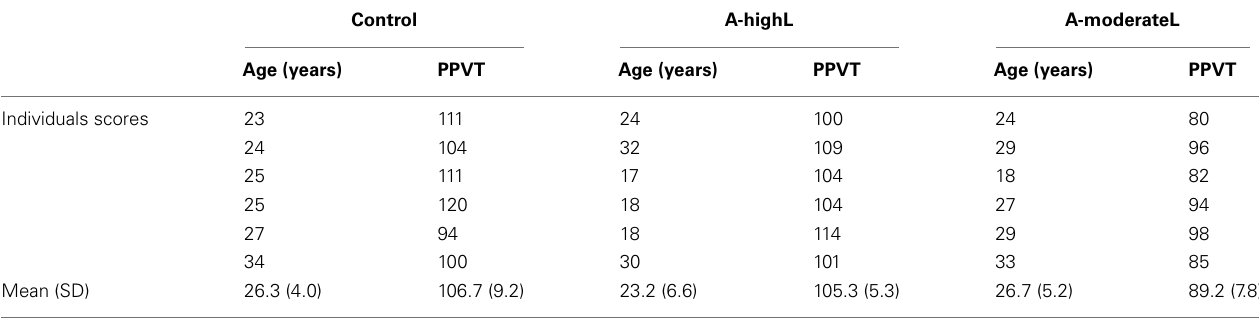
Table 1 | Demographic and background information by